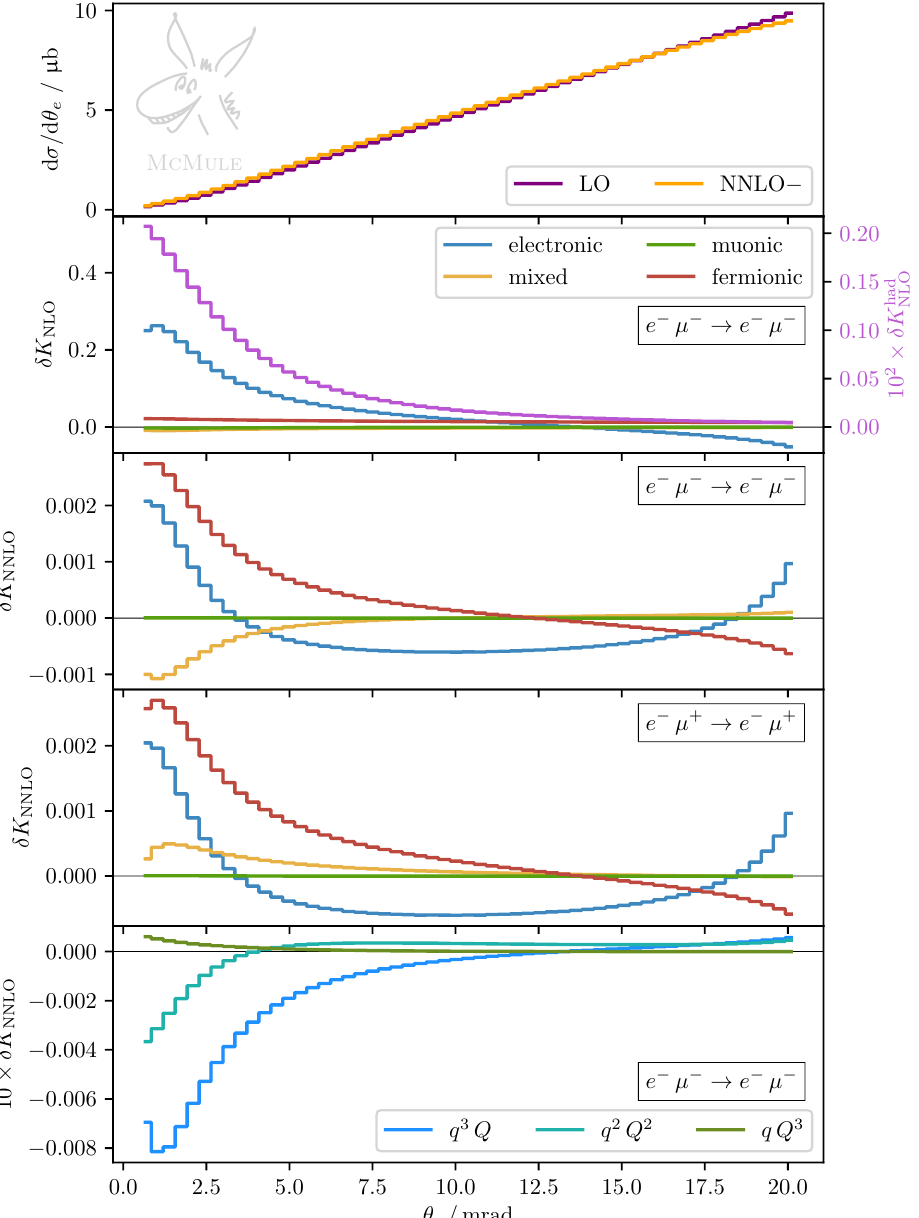
Figure 3 . From top to bottom: (i) differential cross section w.r.t. θ e for S1 at LO (violet), and NNLO (orange) for negative muons; (ii) NLO K factor for negative muons (positive muons have a sign flip for the mixed photonic correction); (iii) NNLO K factor for negative muons; (iv) NNLO K factor for positive muons; (v) NNLO K factor for disentangled mixed photonic corrections, for negative muons. In panels (ii)–(iv) the correction is split into photonic, i.e. electronic, mixed and muonic, and fermionic, including leptonic and hadronic. The hadronic correction at NLO corresponds to the signal of the experiment and is shown separately in purple in panel